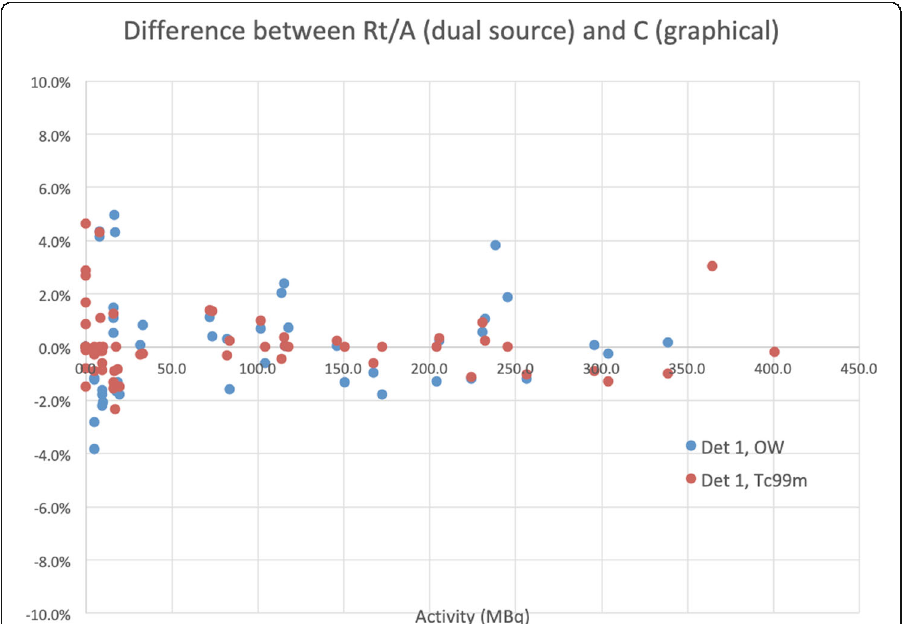
Fig. 5 Comparison of the dual source method and the graphical analysis. Difference between the sensitivity, C (i.e., R t / A ), estimated from count rates corrected with the dual source method, and C from the graphical analysis. The difference is plotted against activity, for the intrinsic measurements. Two low-activity measurements with presumed background (12% and 25% overestimation of activity) and the two points where PDM does not apply (both 49% underestimation) are outside the y -range of this plot.